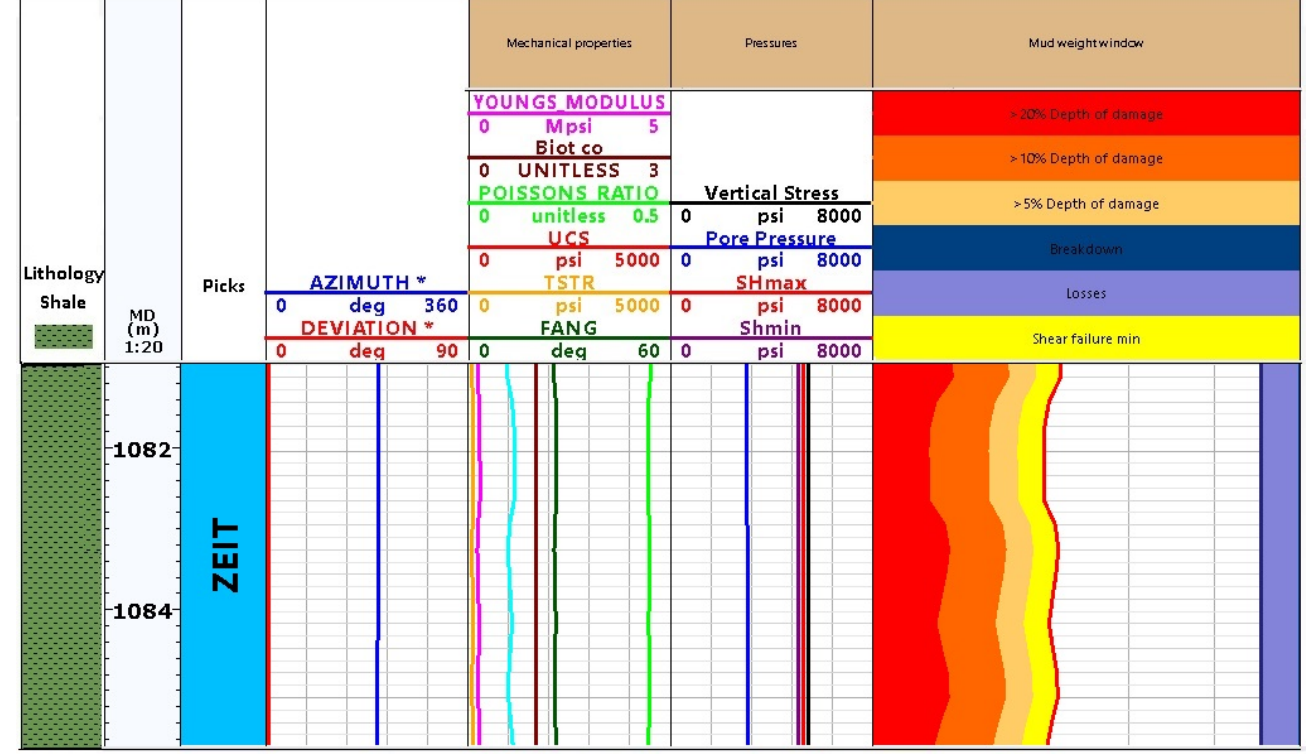
Figure 8. WBS model of Zeit Formation in El Morgan -A1 well. Track 1 (Lithology), Track 2 (Depth), Track 3 (Picks), Track 4 (Hole deviation and Azimuth), Track 5 (mechanical properties), Track 6 (Vertical stress, Shmin, SHmax, and pore pressure), Track 7 (mud weight window). For the different colors in track 7, readers should refer to Figure 4 in this article.